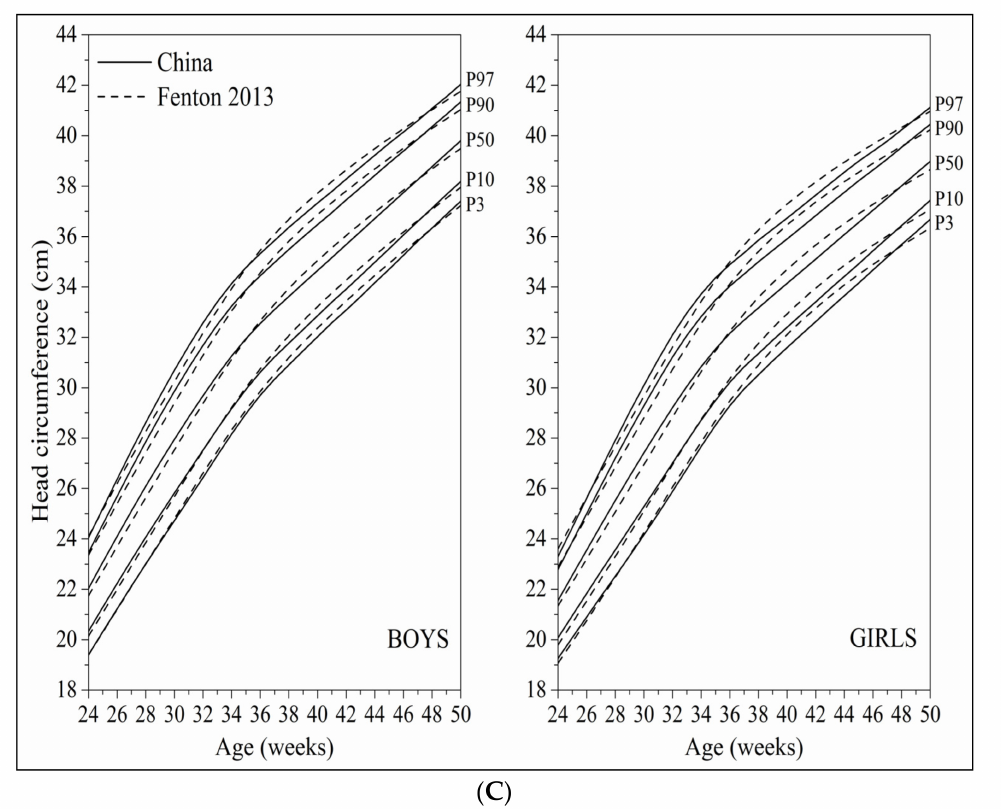
Figure 4. Comparison of the 3rd, 10th, 50th, 90th, 97th percentile curves between the China curves and the Fenton 2013 curves; ( A ) weight; ( B ) length; ( C ) head circumference.